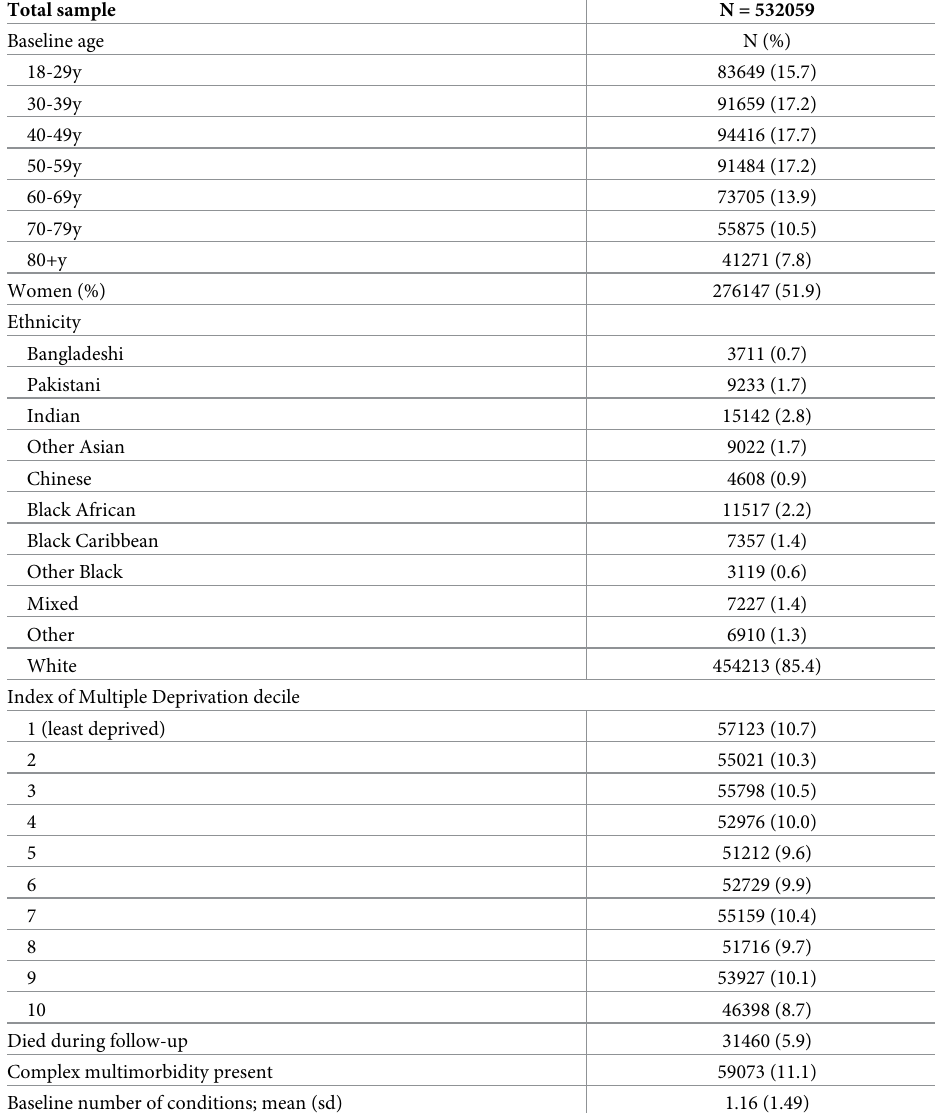
During the 5-year follow-up period, 5.9% of patients died (Table 1). The majority of patients were of White ethnic background (85.4%) and these were older and over-represented in less deprived areas compared with all other ethnic groups (S2 Table). The unadjusted mean num- ber of long-term conditions at baseline was highest in the White ethnic group (1.23) and Table 1. Description of the analytical